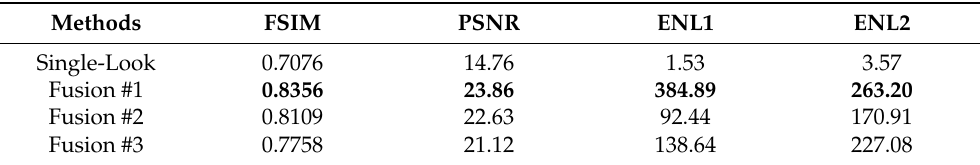
Table 2. The FSIM, PSNR, and ENL of the candidate combinations. (FSIM, PSNR, and ENL1 are computed on S2; ENL2 is computed on RS1.).